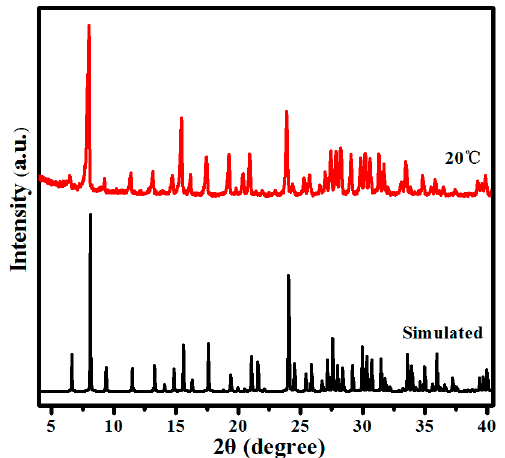
Figure 1. Simulated and experimental X-ray powder diffraction (XRD) patterns of compound 1 in air.